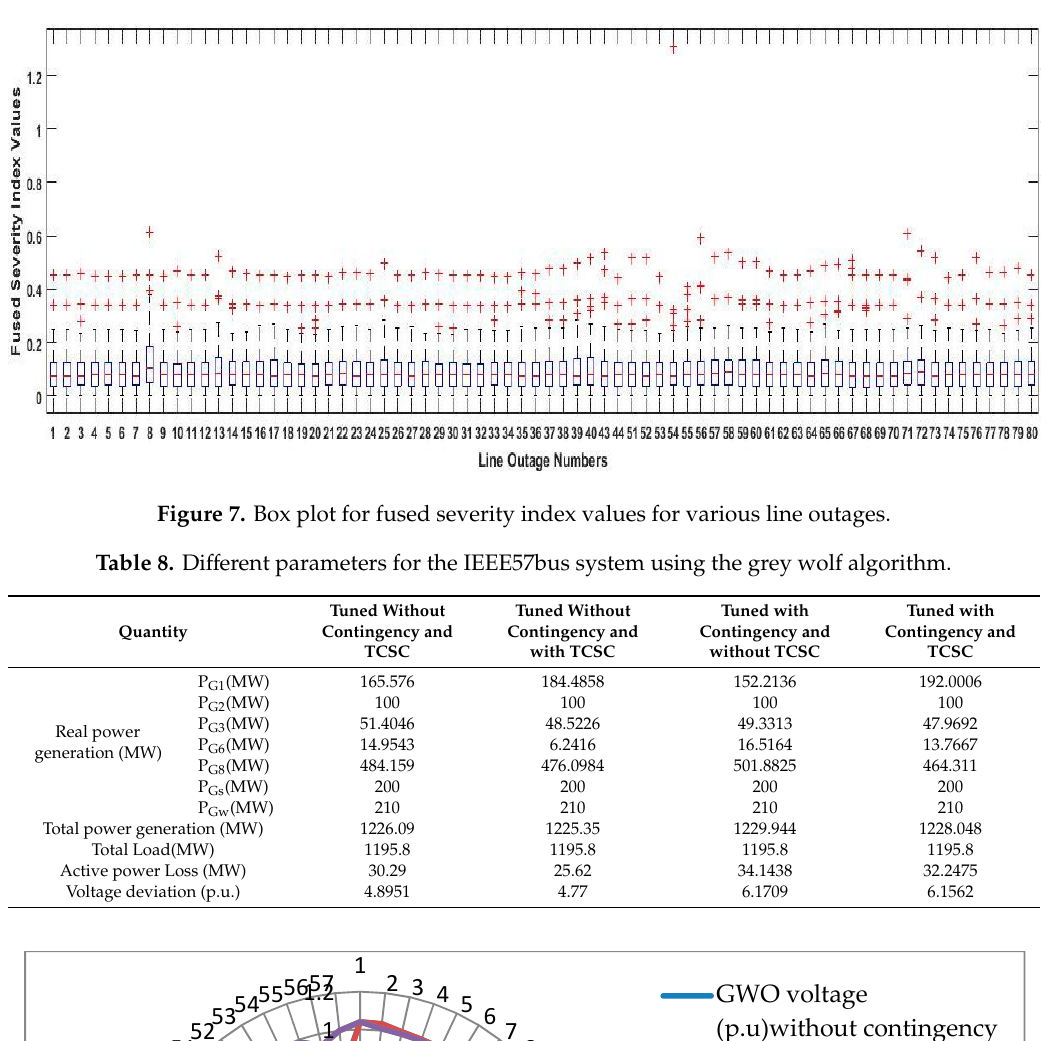
Figure 6. Maximum fused severity index values for various line outages.